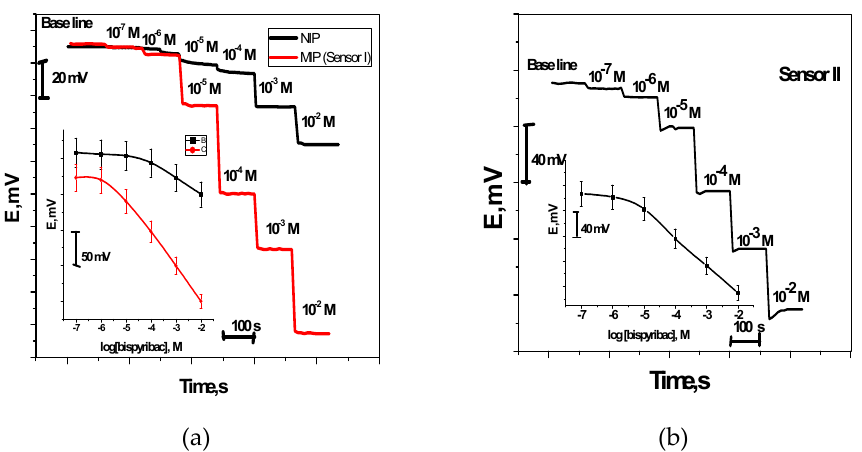
Figure 4. Potentiometric response curves obtained screen-printed ISEs integrated with MIP nanobeads curve ( a ) and aliquat curve ( b ).